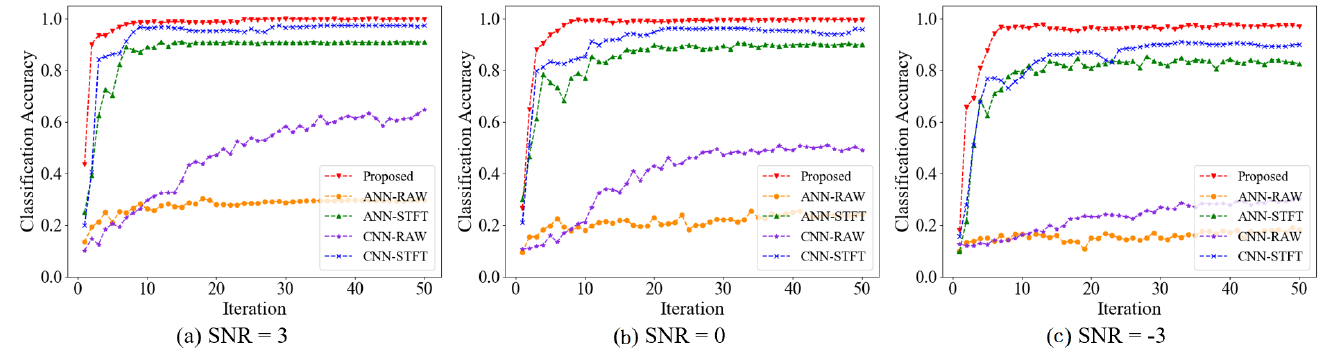
Figure 17. The classification accuracy of different methods under different SNRs (testing on CWRU dstaset).